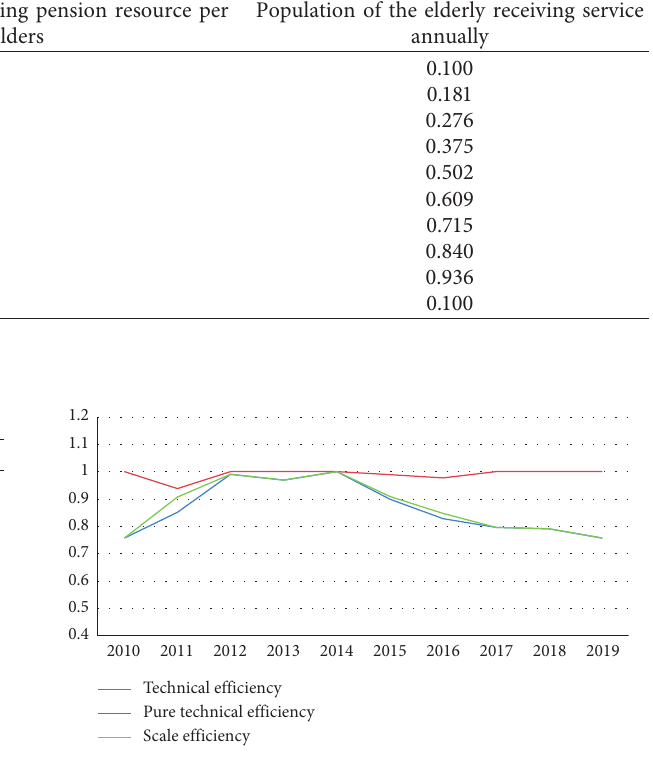
Figure 1: Line graph of technical efficiency, pure technical effi- ciency, and scale efficiency.